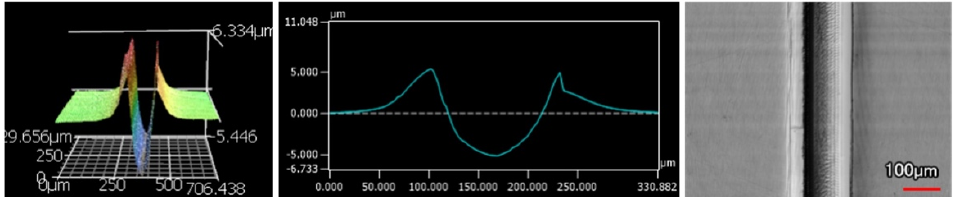
Figure 12. 45 μ m Thick Ni-P Coating 100 Passes of the Sharp Indenter.